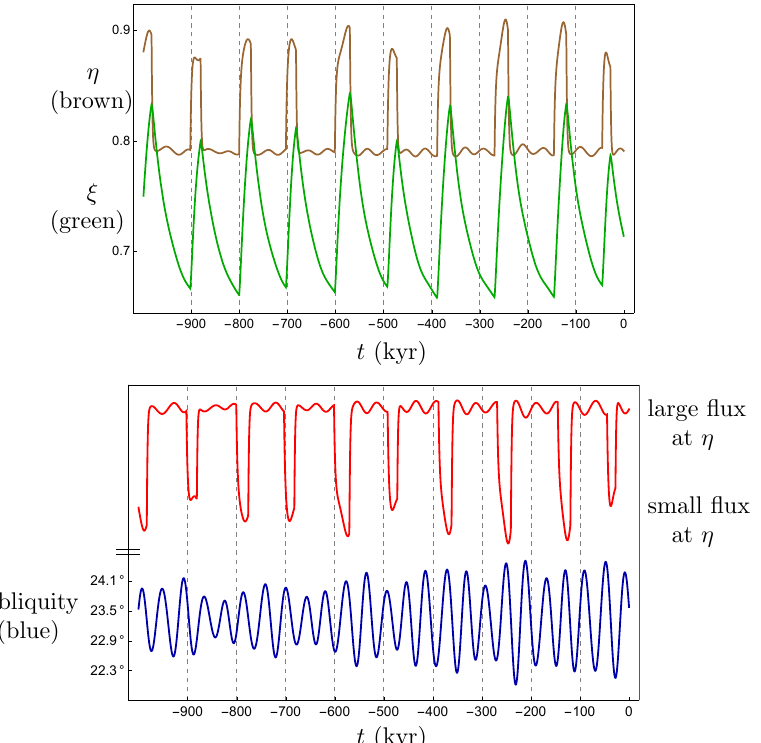
Figure 12. Top : η (brown) and ξ (green) over the past 1 million years, forced by both obliquity and eccentricity. Bottom : Obliquity (blue) and the poleward flux (cid:96) ( η ) (27) (red, scaled) at the albedo line η . D G = 0.3, D I =